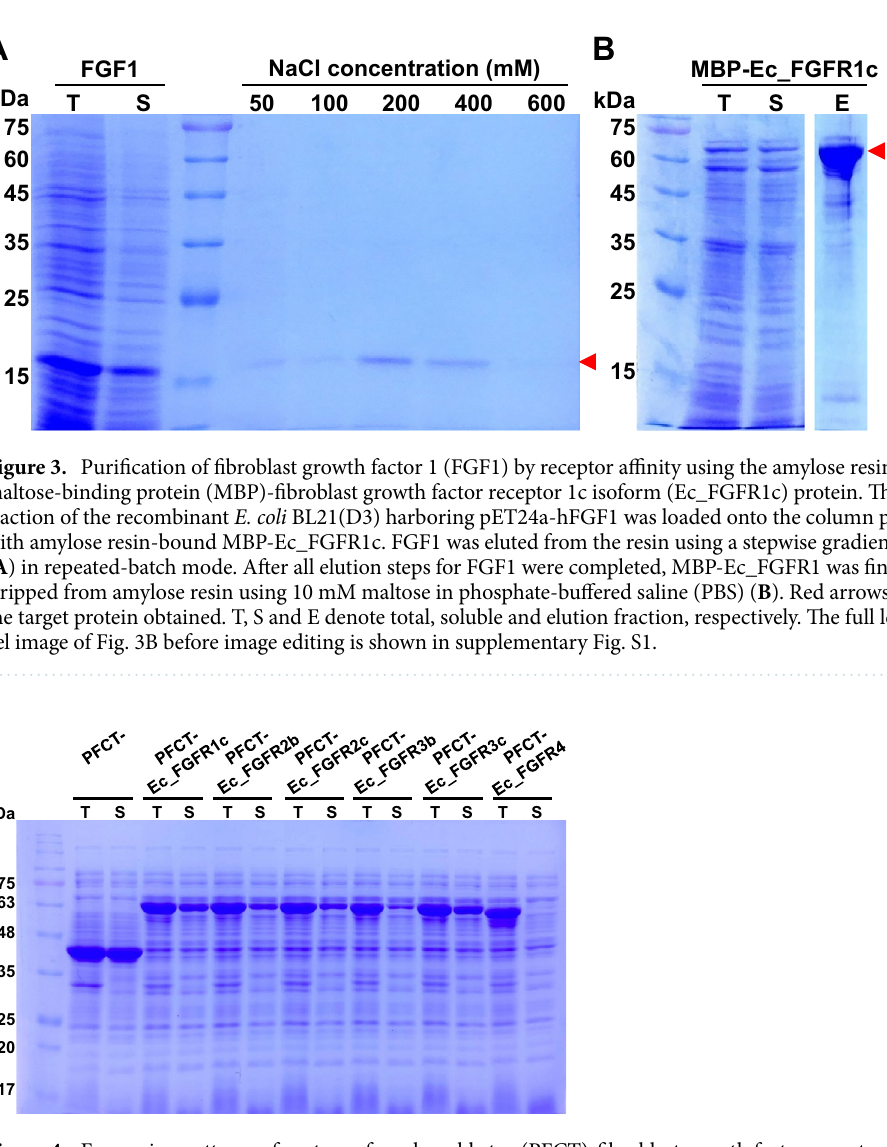
Figure 4. Expression patterns of protease-free cleavable tag (PFCT)-fibroblast growth factor receptor (Ec_ FGFRs) fusion proteins in E. coli XL1-Blue. All constructed PFCT-Ec_FGFRs fusion proteins were expressed in E. coli XL1-Blue under the specified condition described in the experimental section. All clones showed appreciable growth under specified conditions and showed no distinct bands corresponding to the stress-related proteins in SDS-PAGE. T and S denote total and soluble fractions,